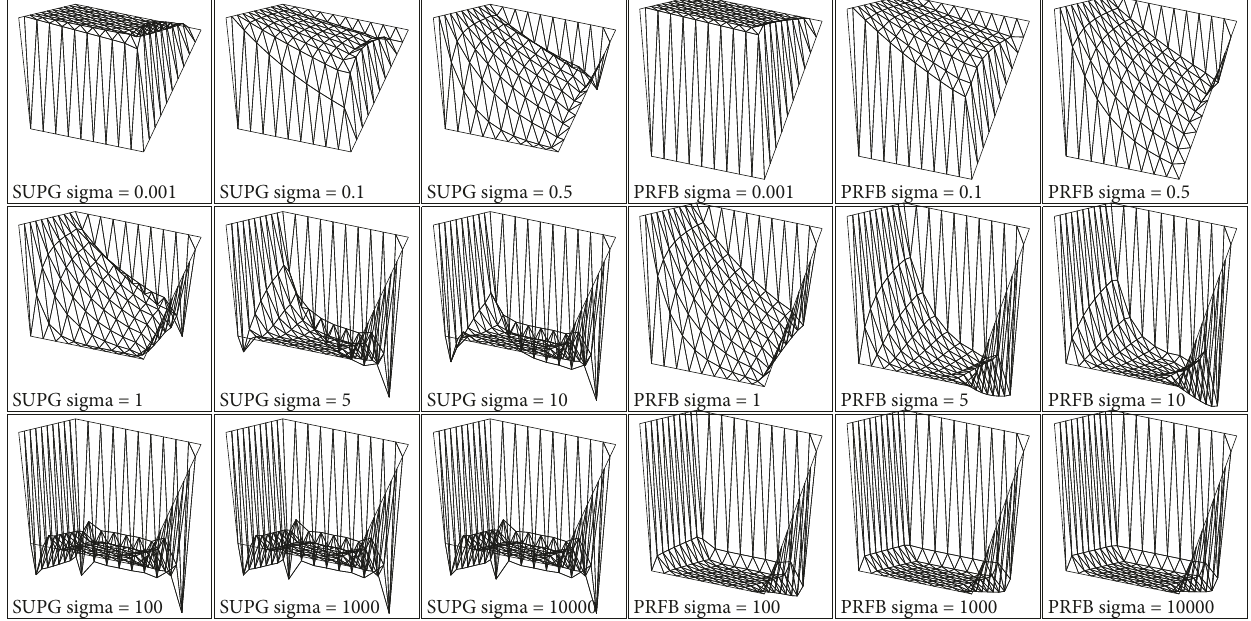
Figure 17: Numerical approximations for Experiment 3 when 𝜖 = 10 −5 , 𝛽 = (2𝑦,0) , and 𝑁 = 10 . SUPG sigma = 0.001